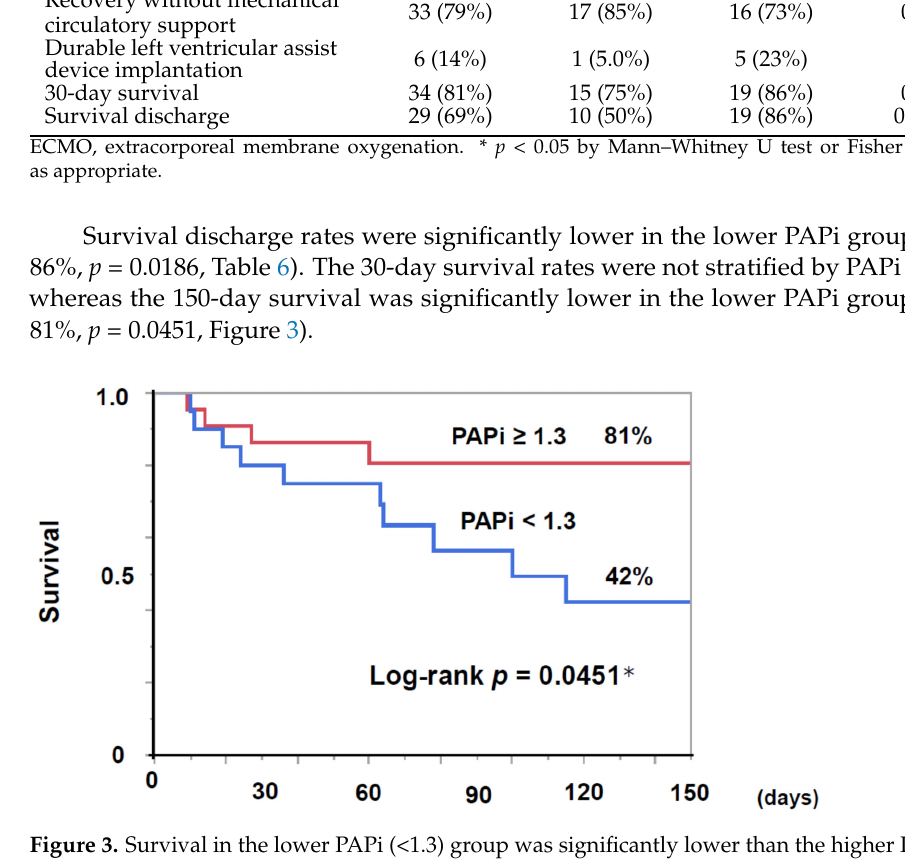
Figure 3. Survival in the lower PAPi (<1.3) group was significantly lower than the higher PAPi ( ≥ 1.3) group (42.3% vs. 80.6%, p = 0.0451) by the Kaplan–Meier analyses and log-rank test. PAPi, pulmonary artery pulsatility index. * p < 0.05 by log-rank test.